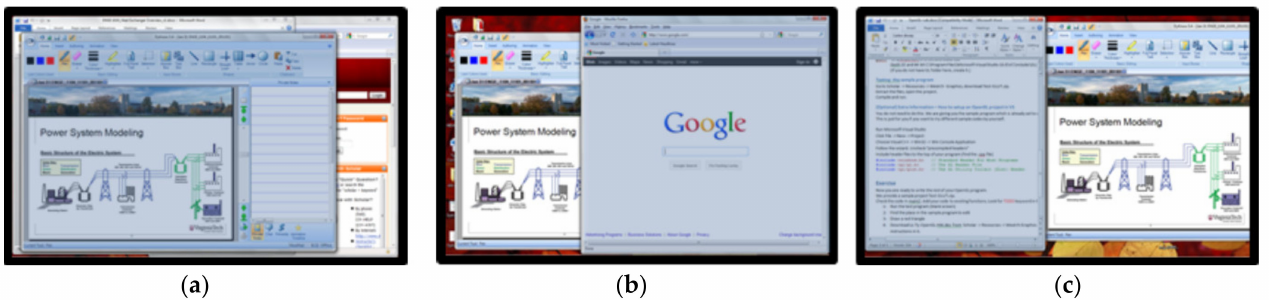
Figure 2. Examples of an active window. ( a ) Focus on DyKnow (on-task). ( b ) Focus on Firefox (off-task).( c ) Focus on Word (off-task).